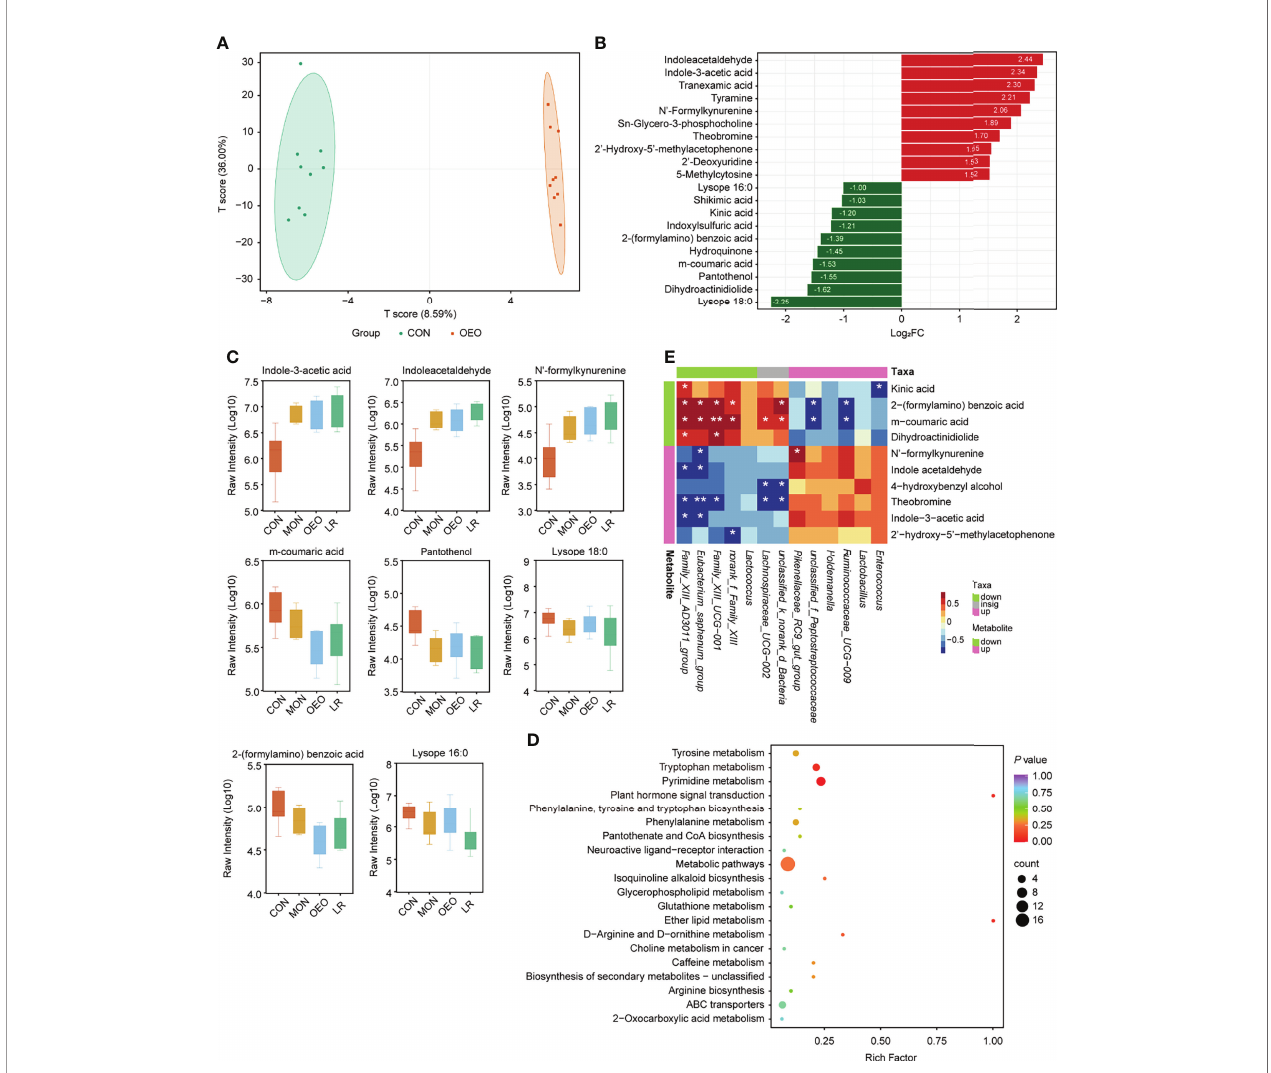
FIGURE 5 | Results of ileum metabolites analysis. (A) OPLS-DA score plots showed signi fi cantly separated clusters between CON and OEO group. (B) Bar-chart showing the fold change of top 20 different metabolites. (C) Box-plot of each signi fi cantly different metabolite peak area (Log10 transformed) among treatments. Data was presented as median and whiskers represented the Tukey. (D) The KEGG functional enrichment analysis of differential metabolites (CON vs OEO). (E) Correlation analysis of microbiota and metabolites in the ileal contents between CON and OEO groups. Red represents a signi fi cant positive correlation ( P < 0.05), while blue represents signi fi cantly negative correlation ( P < 0.05). Asterisks indicate signi fi cant difference between the trial group and the CON group (*0.01 < P ≤ 0.05; **0.001 < P ≤ 0.01; *** P ≤